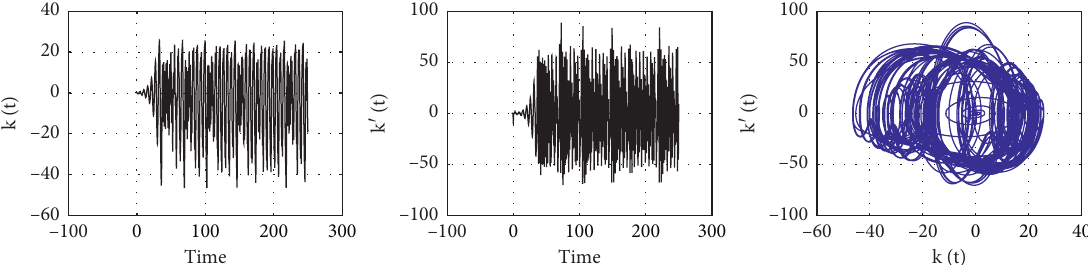
Figure 12: Solutions and phase trajectories at a � 0.125, q � 0.5, and τ � 2.5.